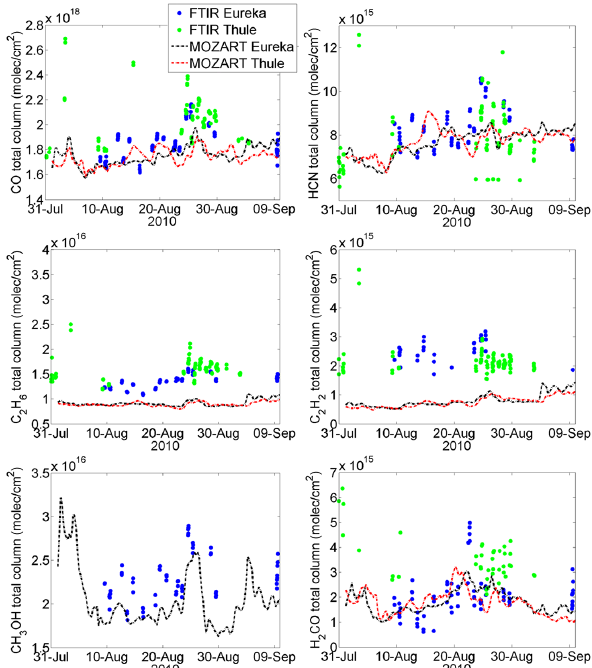
Figure 6. Time series of CO, HCN, C 2 H 6 , C 2 H 2 , CH 3 OH, and H 2 CO total columns measured by the FTIRs at Eureka (blue) and Thule (green) and calculated by MOZART-4 at Eureka (black) and Thule (red) for the August 2010 fire